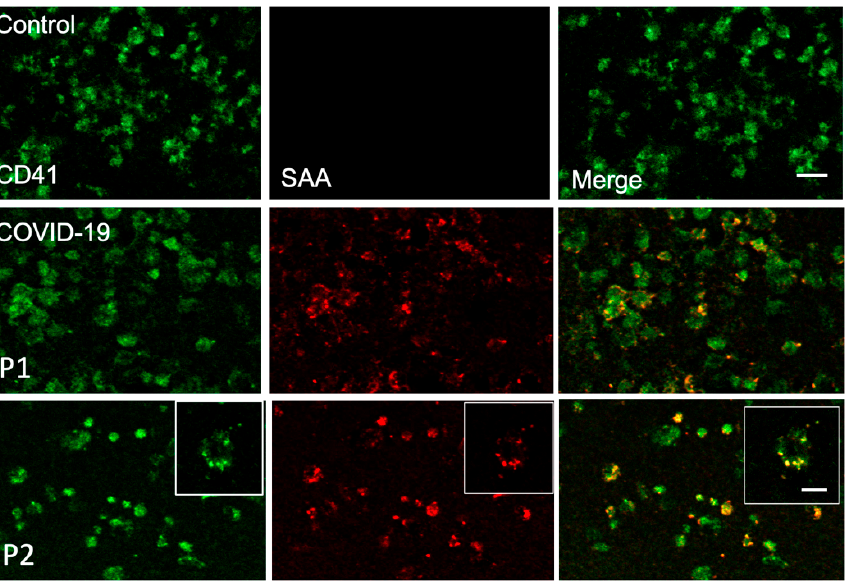
Figure 3. SAA partially colocalizes with CD41. Immunofluorescence was performed on washed platelets from a healthy control and COVID-19 patients ( n = 3) using anti-SAA (red) and -CD41 (green) specific antibodies. Images were obtained using confocal microscopy. Inset: an enlarged platelet cluster showing partial colocalization. Bar = 5 µm.